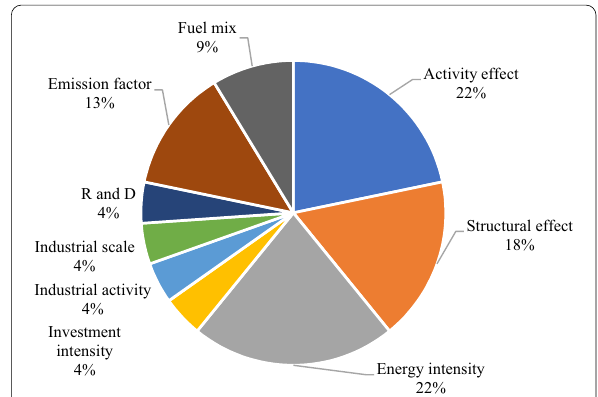
Fig. 13 Percentage variation of CO 2 emission drivers across study